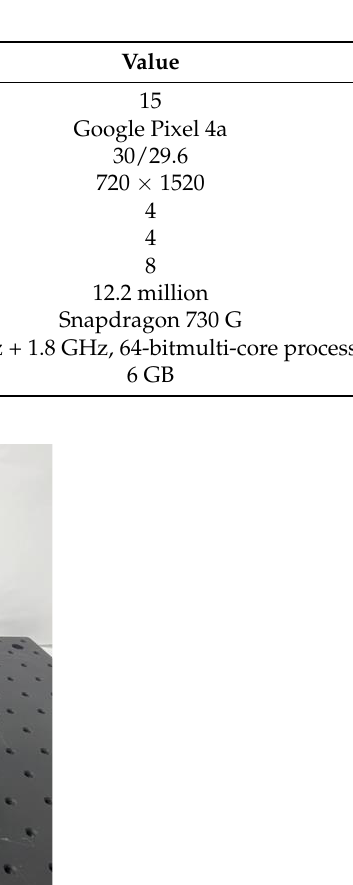
Figure 6. The VLC system architecture with two mobile devices mounted on the platform.